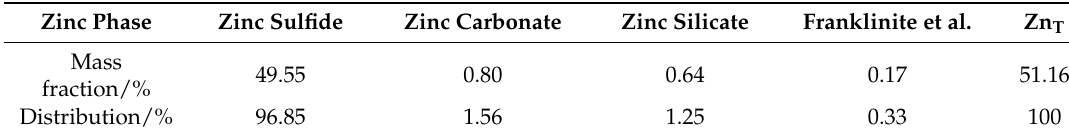
Table 2. Zinc phase distribution of zinc sulfide concentrate.